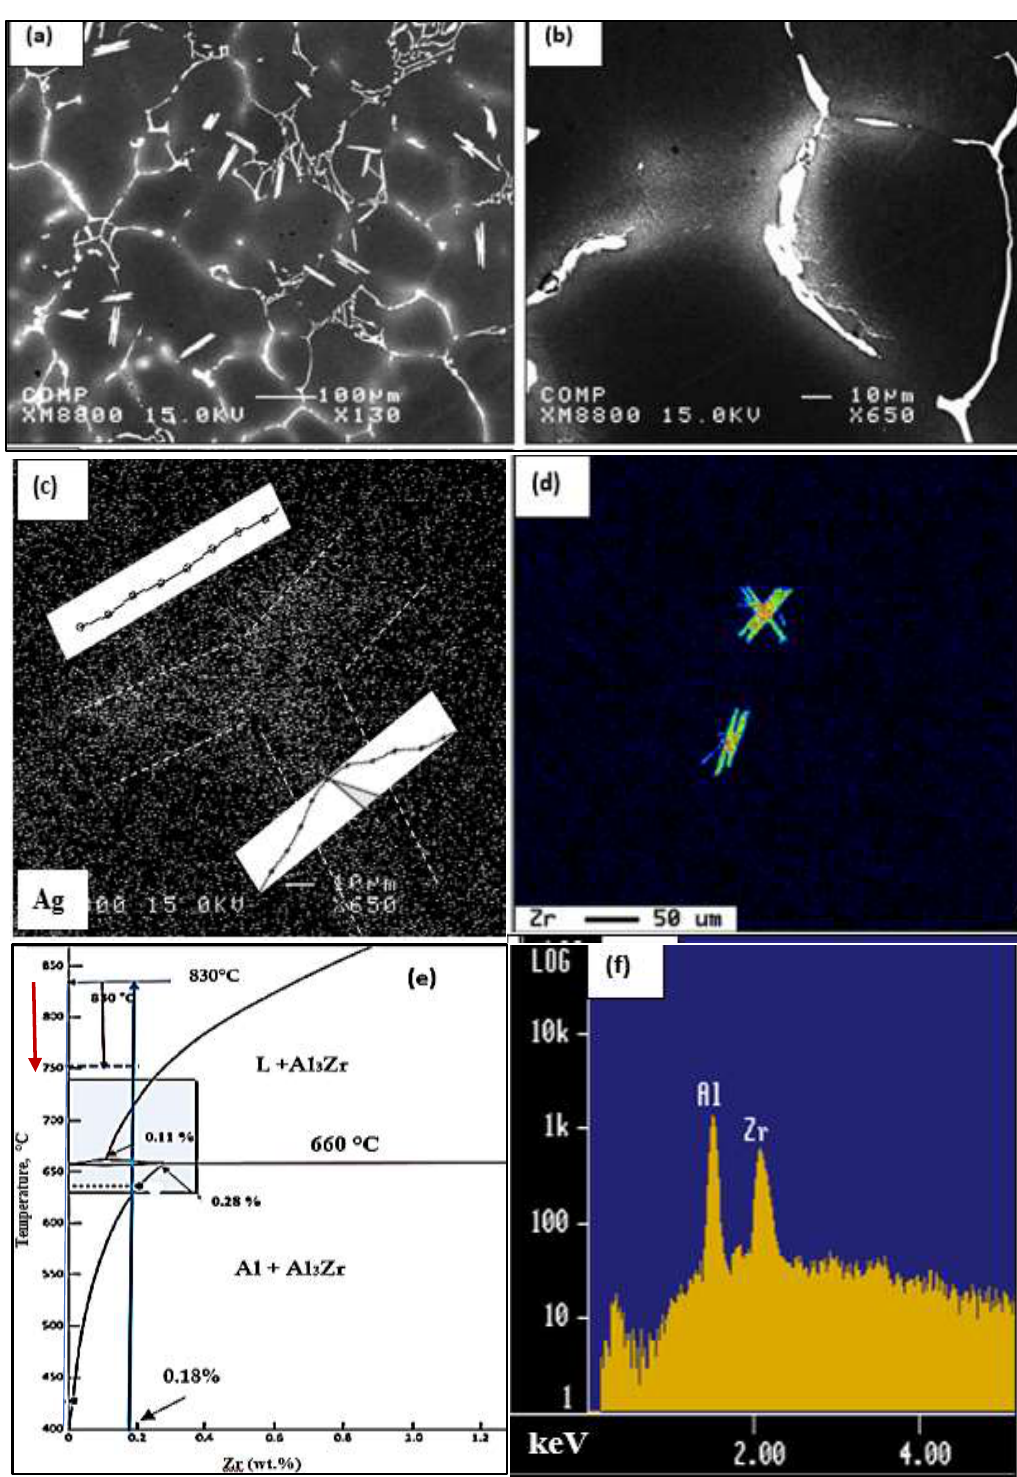
Figure 3. Phase precipitation in alloy C in the as-cast condition: ( a ) backscattered electron image of alloy C; ( b ) high magnification of ( a ) showing segregation of Ag towards the alloy grain boundaries as confirmed with the x-ray image in ( c ); ( d ) X-ray image of Zr precipitated particles; ( e ) Al-Zr binary diagram. The blue arrow points to the melting temperature, whereas the red arrow indicates the pouring temperature where Al 3 Zr phase particles in ( a , d ) were precipitated; ( f ) EDS spectrum corresponding to the Al 3 Zr particle in ( d ). The inset in ( b ) reveals the peak distribution between the white